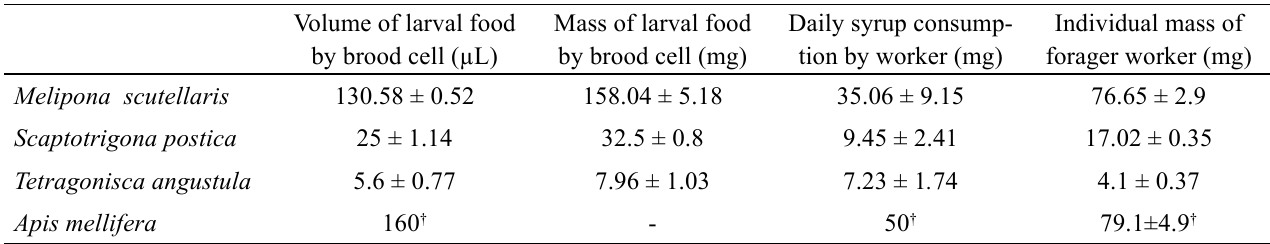
Table 1 . Amount of larval food consumption by cell, daily syrup consumption and individual weight of forager workers.± indicates standard deviations values. “–” indicates absence of